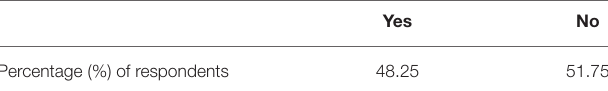
TABLE 12 | Responses to the question “Would you boycott visiting a country involved in whaling?”